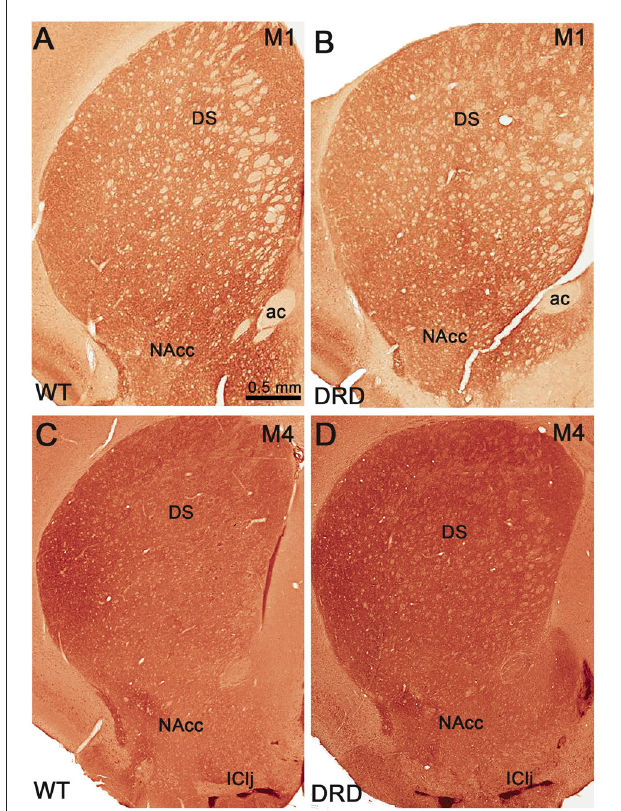
FIGURE 7 | (A–D) Low power views of striatal sections that compare M1 (A,B) and M4 (C,D) muscarinic receptors immunoreactivity between WT (A,C) and DRD (B,D) mice. Abbreviations: ac, anterior commissure; DS, dorsal striatum; IClj, Island of Calleja; NAcc, nucleus accumbens. Scale bar in (A) valid for (B–D)